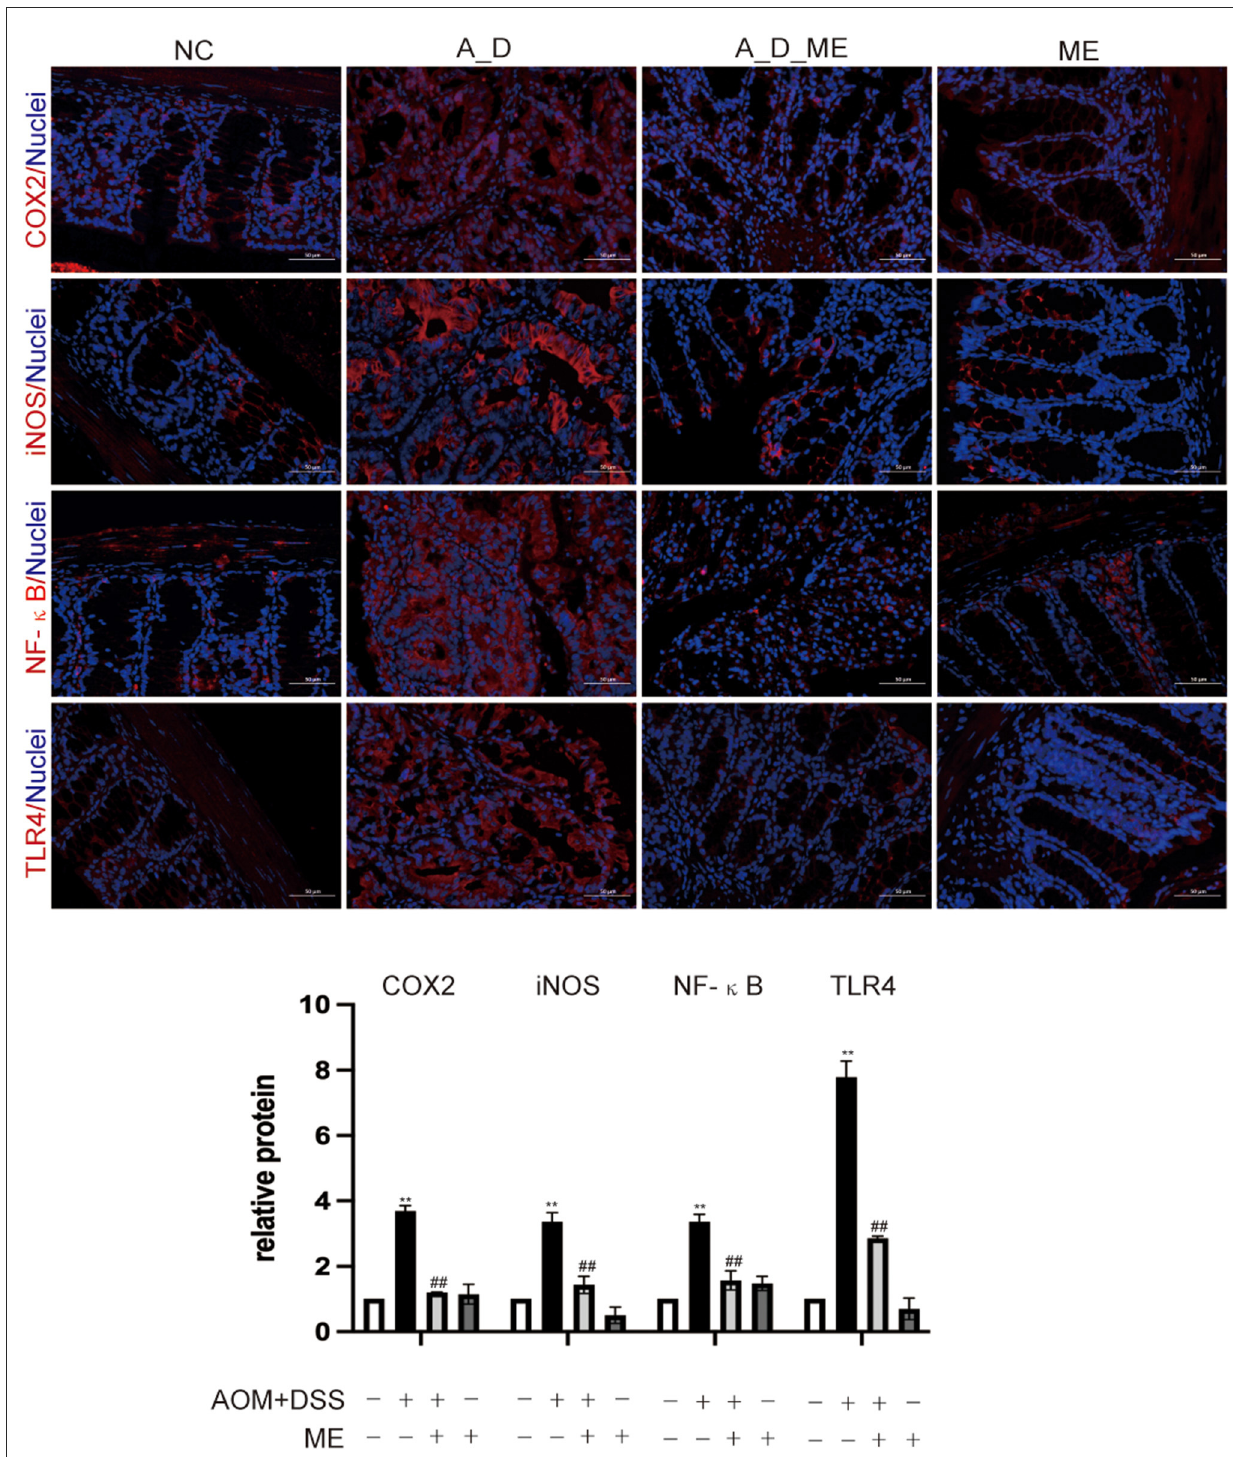
FIGURE4 Aberrant regulation of TLR4 and NF- κ B signaling pathway in the large intestinal tissues. COX2, iNOS, NF- κ B, and TLR4 were assessed by immunofluorescence staining of the mice colonic slides in four groups (400 × magnification). Histogram showing the percent of positive staining in the tissue. Data represent the mean ± SD, ## p < 0.01 compared with normal control, ** p < 0.01 compared with the model group. N =